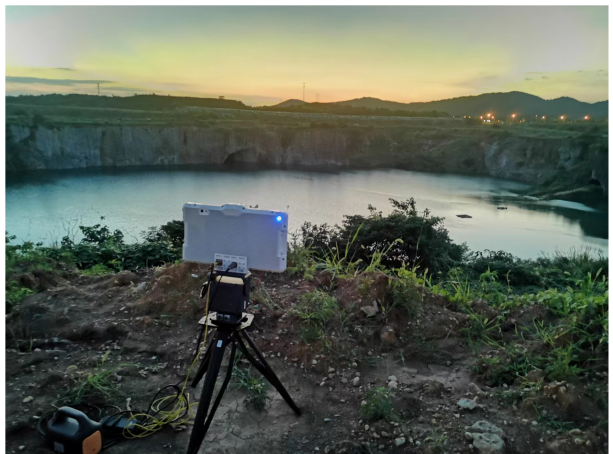
Figure 16. Experimental scene.